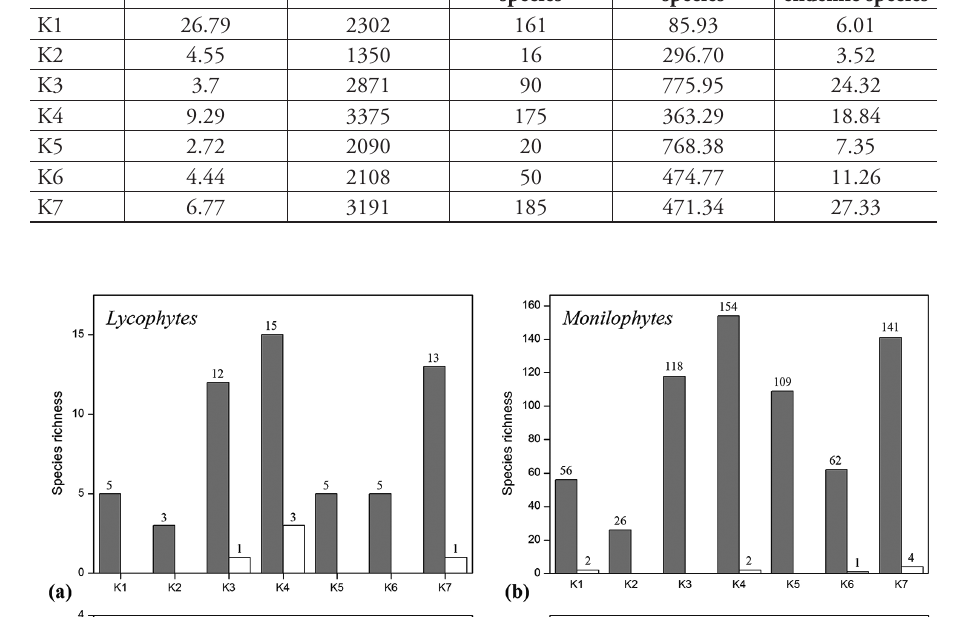
Table 4. The number and density of total and endemic species in K1–K7 regions in Kenya. Regions Area/10000 km 2